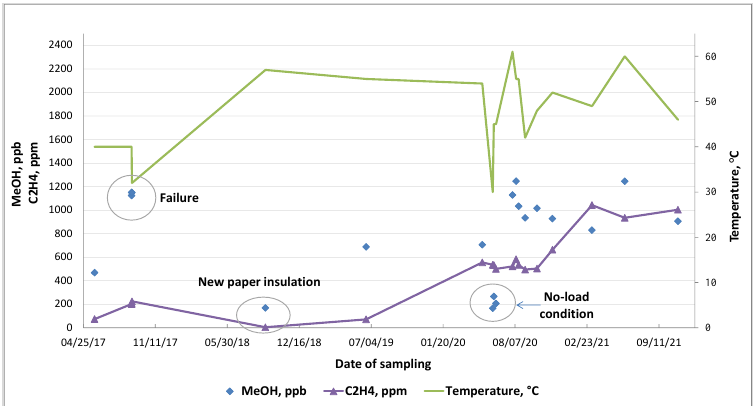
Figure 6. Change in methanol and ethylene concentrations before and after the failure.